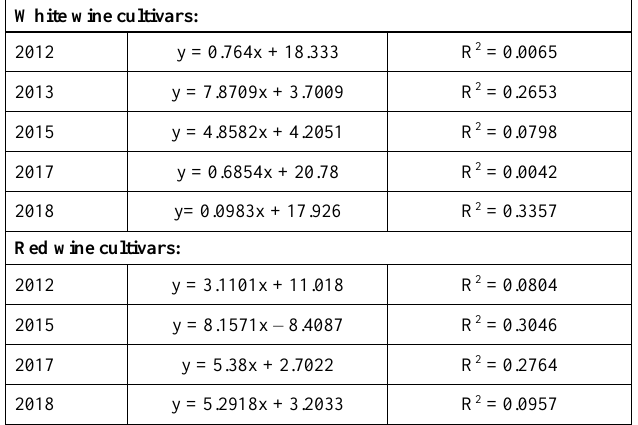
Table 1. Regression equations of ripening parameters for white and red wine grapes (Debrecen - Pallag, 2012-2018) White wine